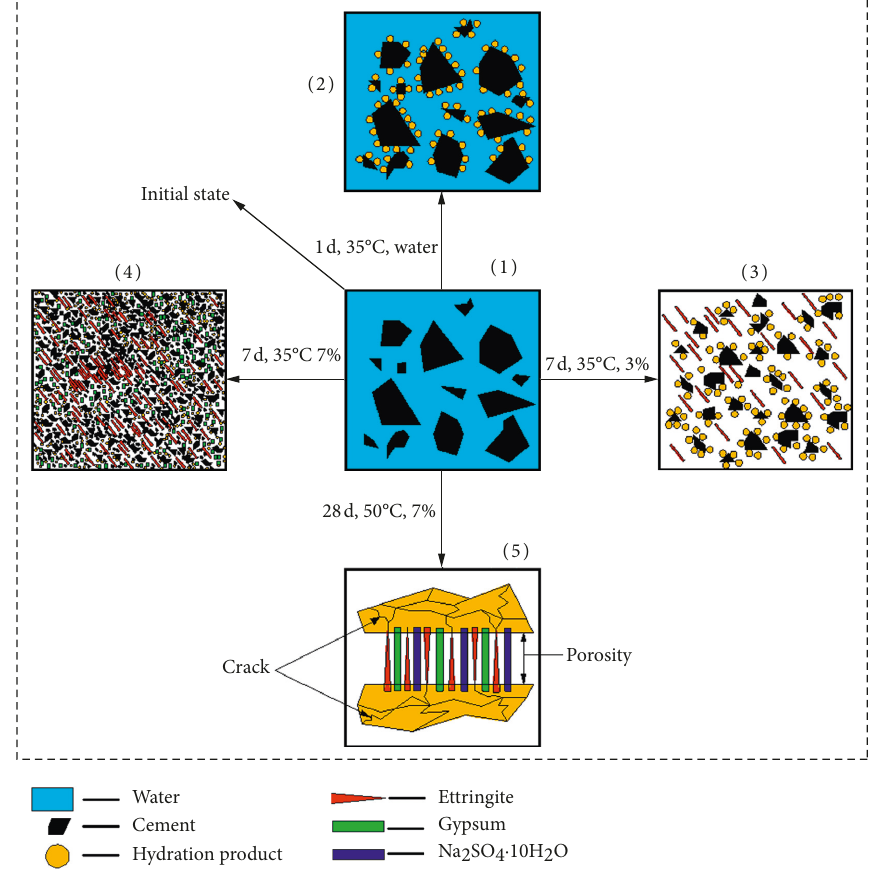
Figure 5: Model of deterioration mechanism of CPB under TC coupling condition.